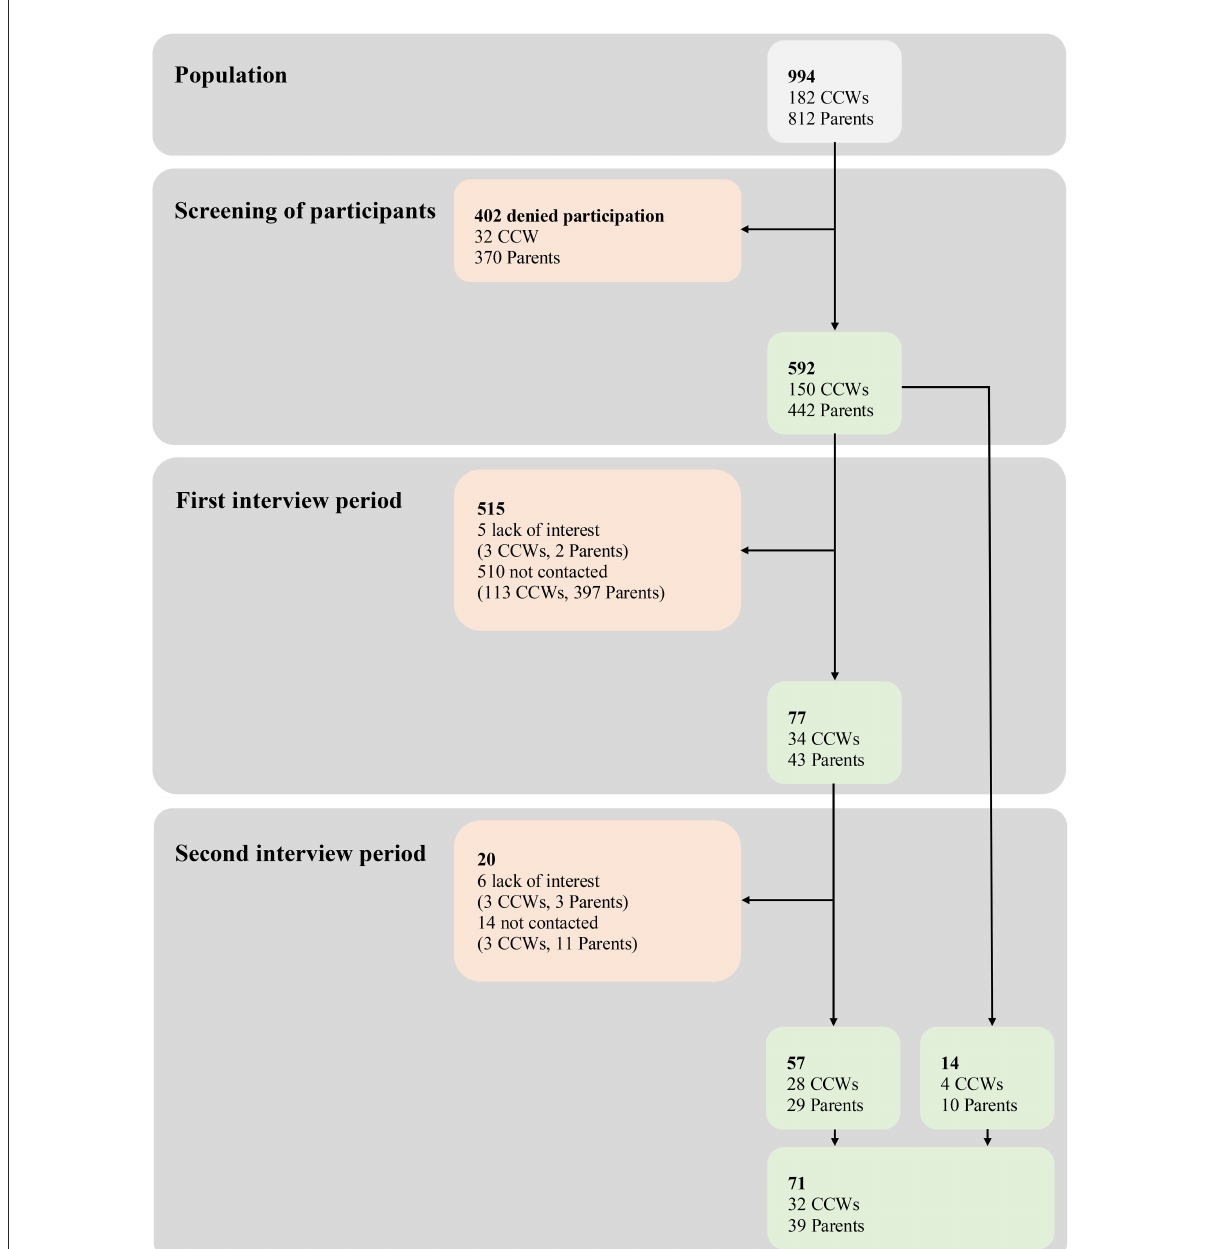
FIGURE1 Flow of participants throughout the study with reasons for inclusion/exclusion. Light gray, parents and CCWs belonging to the nine DCCs involved in Wü-KiTa-CoV and screened for interest in being interviewed; light green, parents and CCWs included; light red, parents and CCWs excluded (with